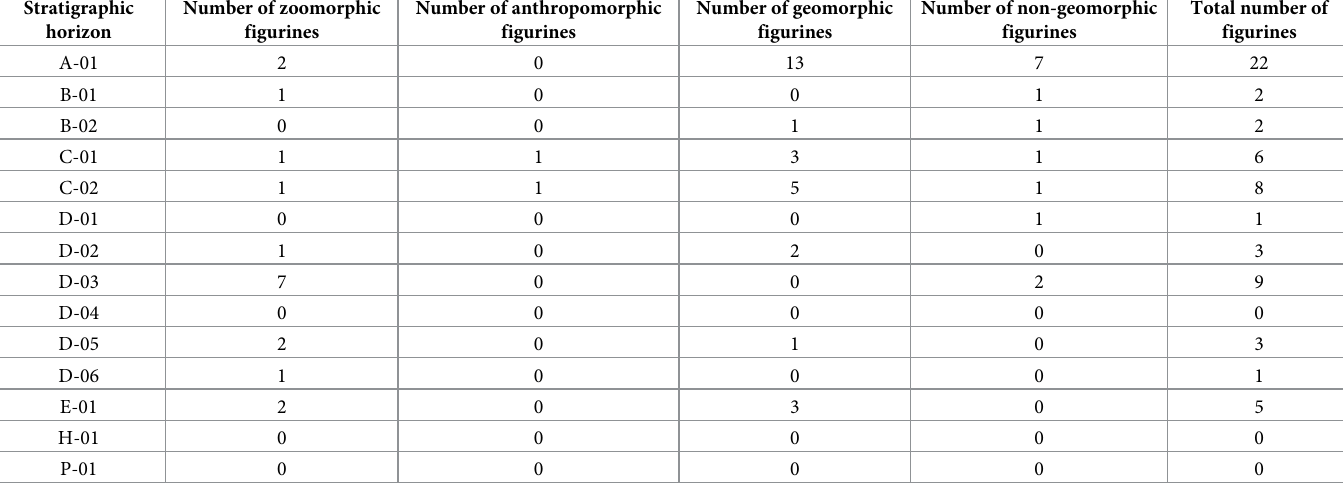
Table 2. Counts of clay objects for each level identified in the West Trench (Fig 5). Level N-01 is the natural ‘virgin soil’ devoid of traces of human activity and is thus excluded. Stratigraphic